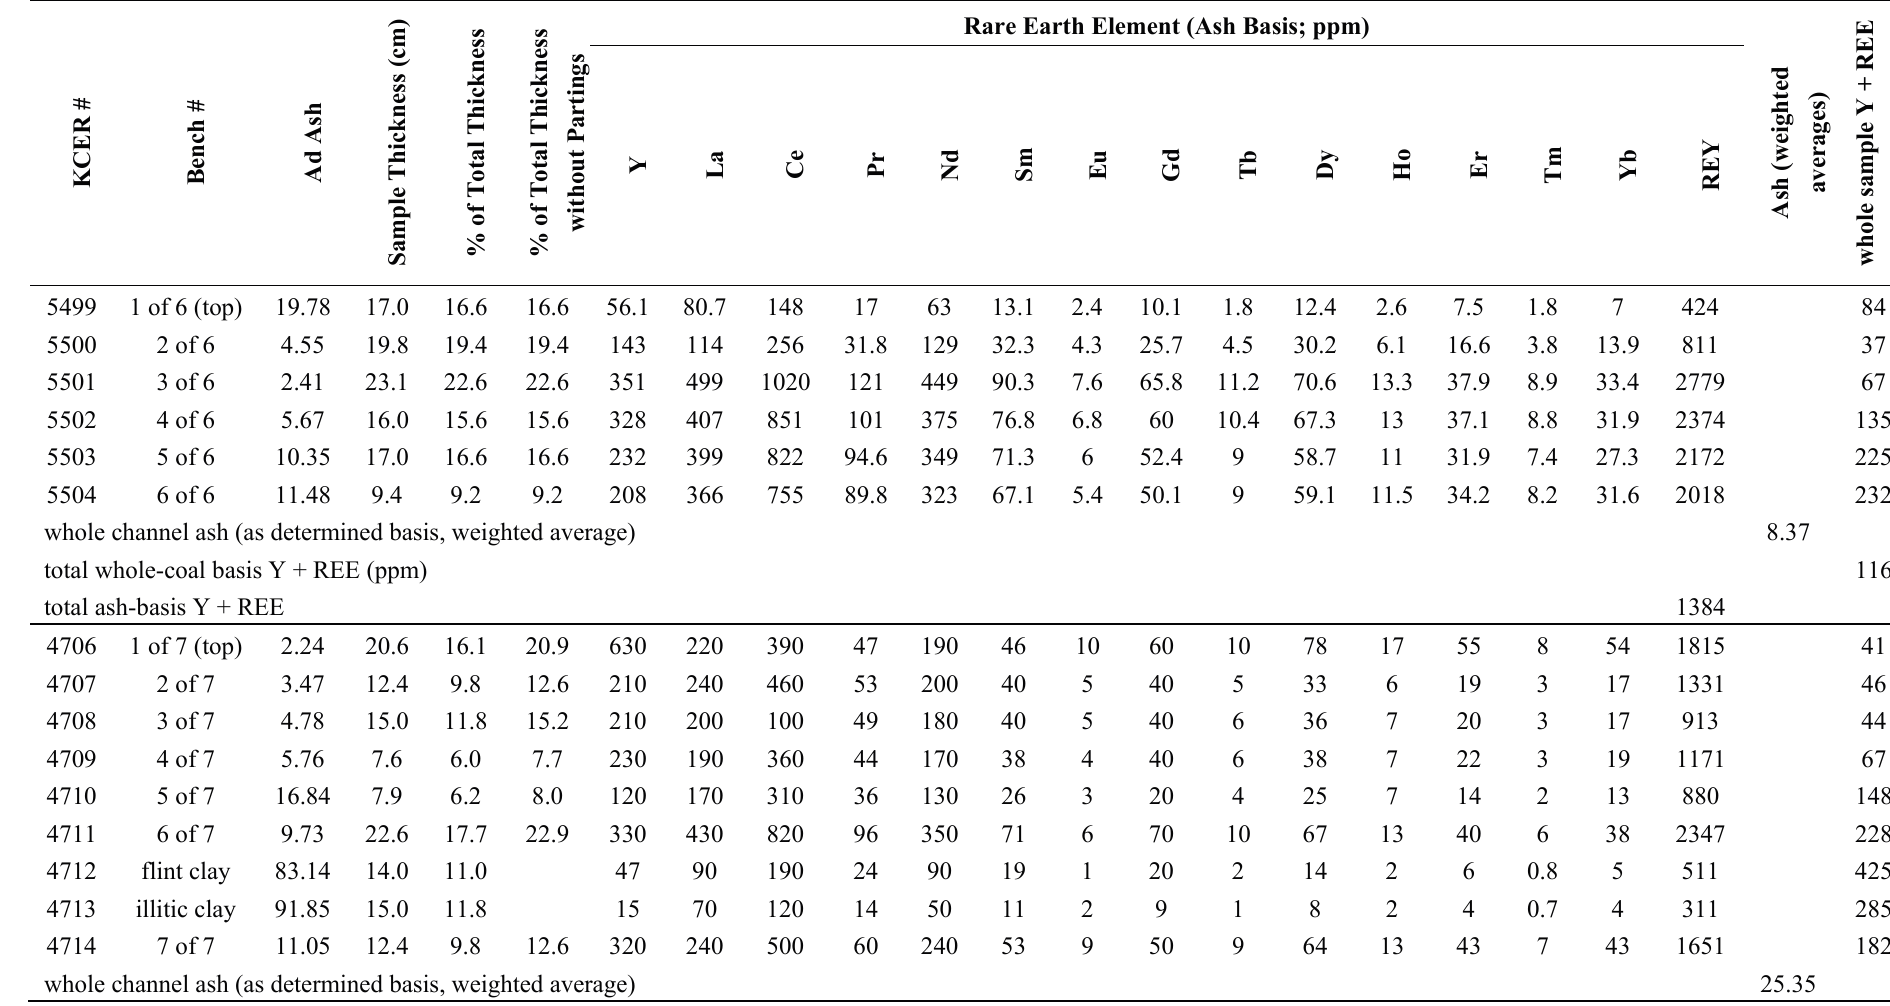
Table 2. Rare earth elements and yttrium for three distinct settings of the Fire Clay coal: (1) samples 5499-5504—no tonstein parting but high REY concentrations [3], (2) samples 4706-4714—tonstein overlying an illitic clay parting [2], and (3) samples 4754-4767—tonstein without an illitic clay